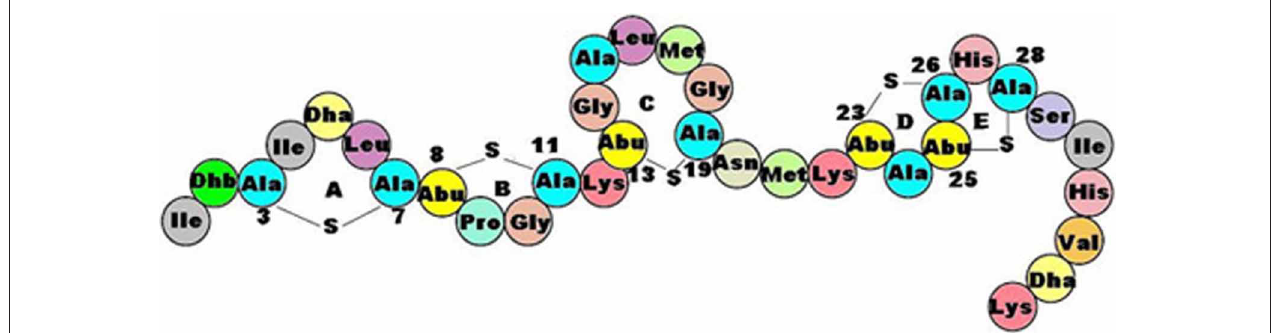
FIGURE 6 | General structure of a lantibiotic: covalently bound alanines and post-translationally modified amino acids are peculiar features of these anti-microbial peptides.